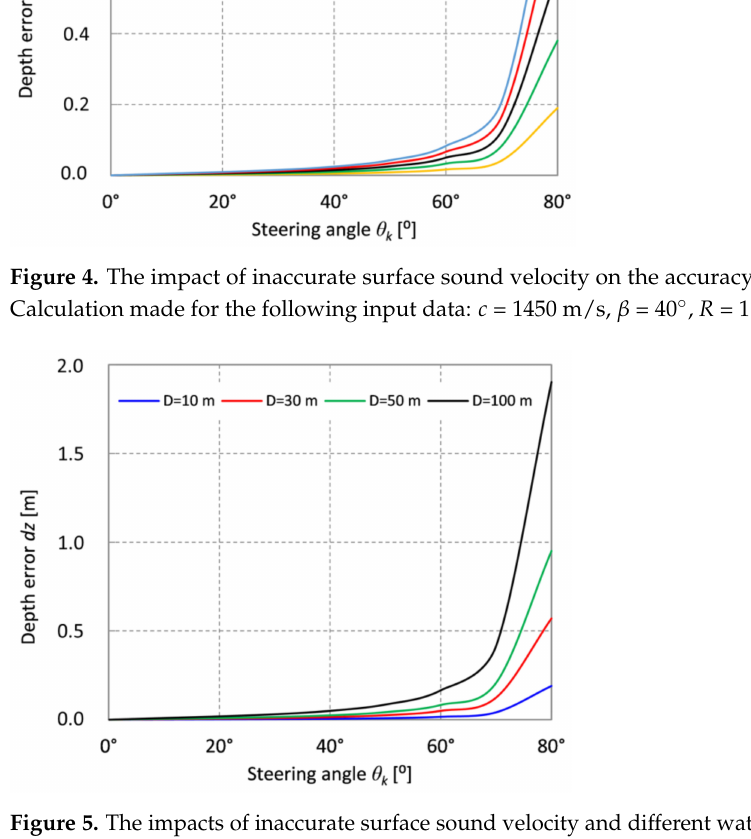
Figure 5. The impacts of inaccurate surface sound velocity and different water are on the accuracy of depth measurement. Calculation made for the following input data: c = 1450 m/s, β = 40 ◦ , R = 1 ◦ , D = 10, 30, 50, and 100